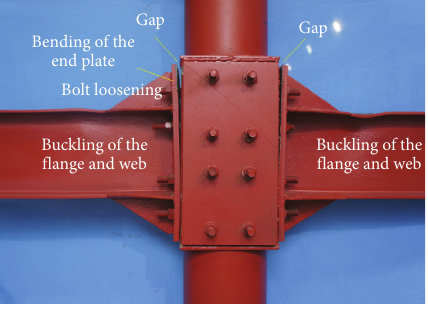
Figure 10: Failure modes of J-4.